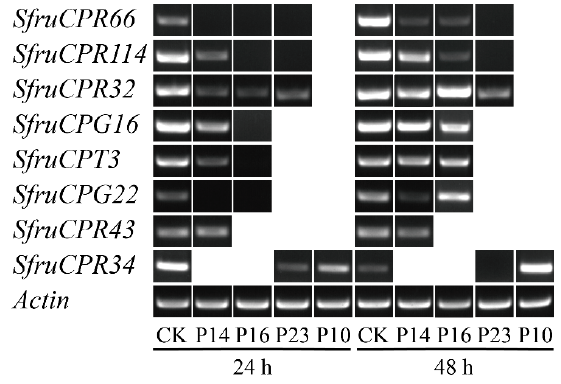
Figure 3. The detailed fold changes of CP genes after exposure to different insecticides. The detailed information of differ- ent insecticides corresponding to their codes (above the heat map) are represented in Table 2. Transcriptional levels were expressed as mean fold changes to the control. The red and green colors represent the up and down regulation of CP gene expression by different insecticides, respectively. The detailed fold change values on the left and the differentially ex- pressed CP genes on the right are shown, which are below the insecticide codes.